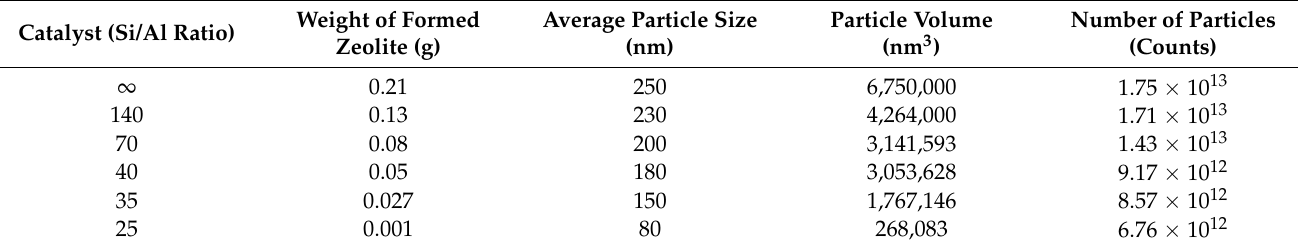
Table 1. Weight and number of particles of the zeolites with different SARs *.